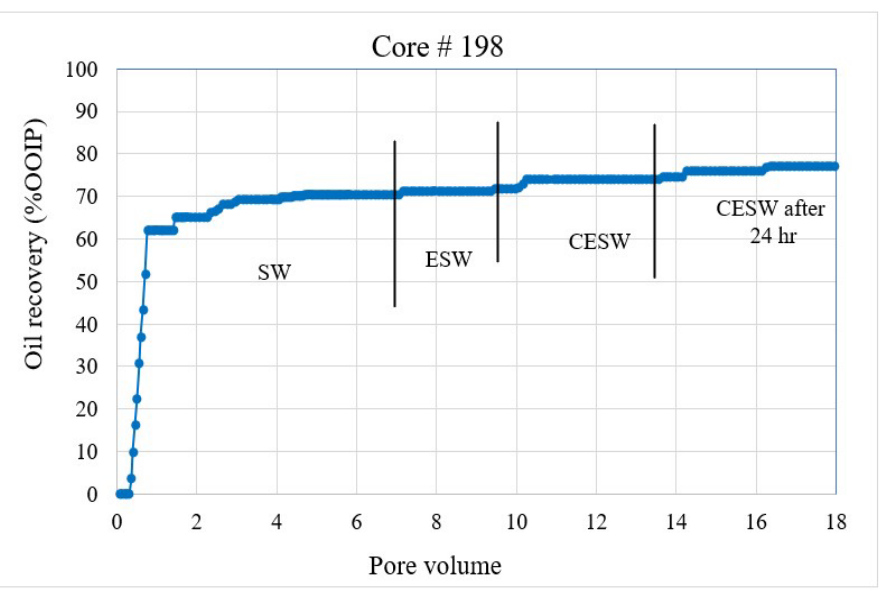
Figure 3. Coreflood with low permeability core plug (K = 1.5 mD). (CF-2 conducted on core plug #198).